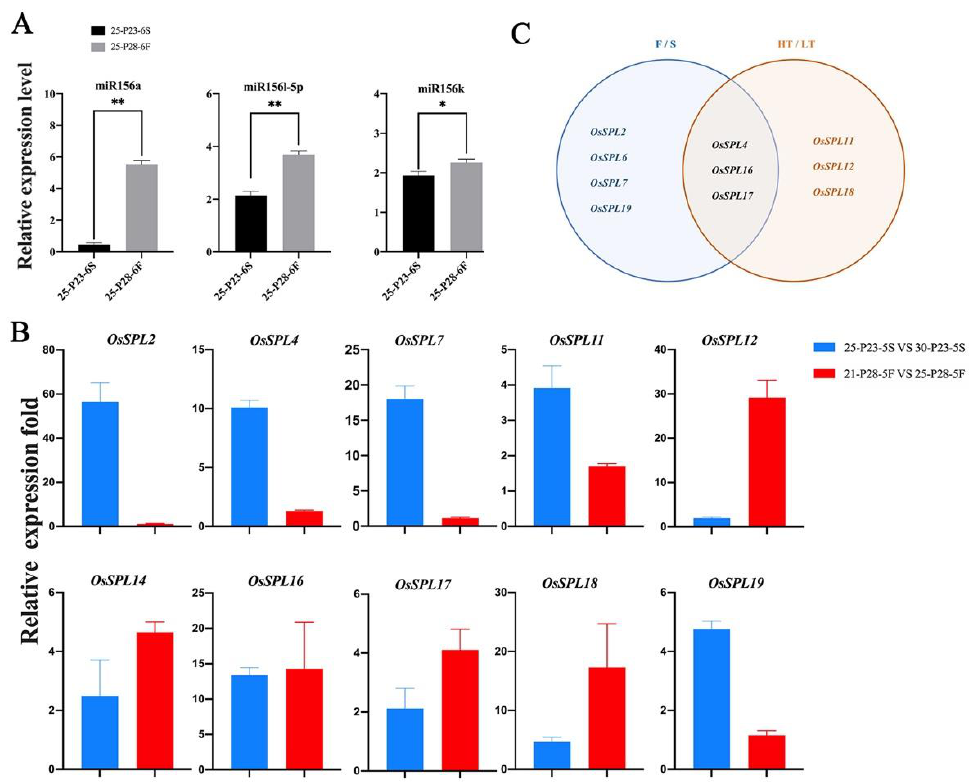
Figure 4. Expression of miR156/ OsSPL module genes in sterile and fertile panicles of PA2364S and PA2864S at different temperatures. ( A ) Expression levels of miR156a, miR156k and miR156l-5p at sixth stages of 25 °C treatment in PA2364S and PA2864S. ( B ) Relative expression folds of the OsSPL genes targeted by miR156 responding to temperature changes. ( C ) Venn diagram of OsSPL genes in response to fertility changes and temperature changes. Here,25: treated at 25 °C. P23/P28: PA2364S/PA2864S. Here, 6S/6F: sixth stage sterile or fertile plants. The blue bars in Figure 4 indicate the fold difference in gene expression between 25 °C and 30 °C treatment in P23 sterile plants, and the red bars indicate the fold difference in gene expression between 21 °C and 25 °C treatment in P28 fertile plants. For each treatment, the qPCR results show the average of three replicates. Here, p (*) < 0.05, p (**) < 0.01.